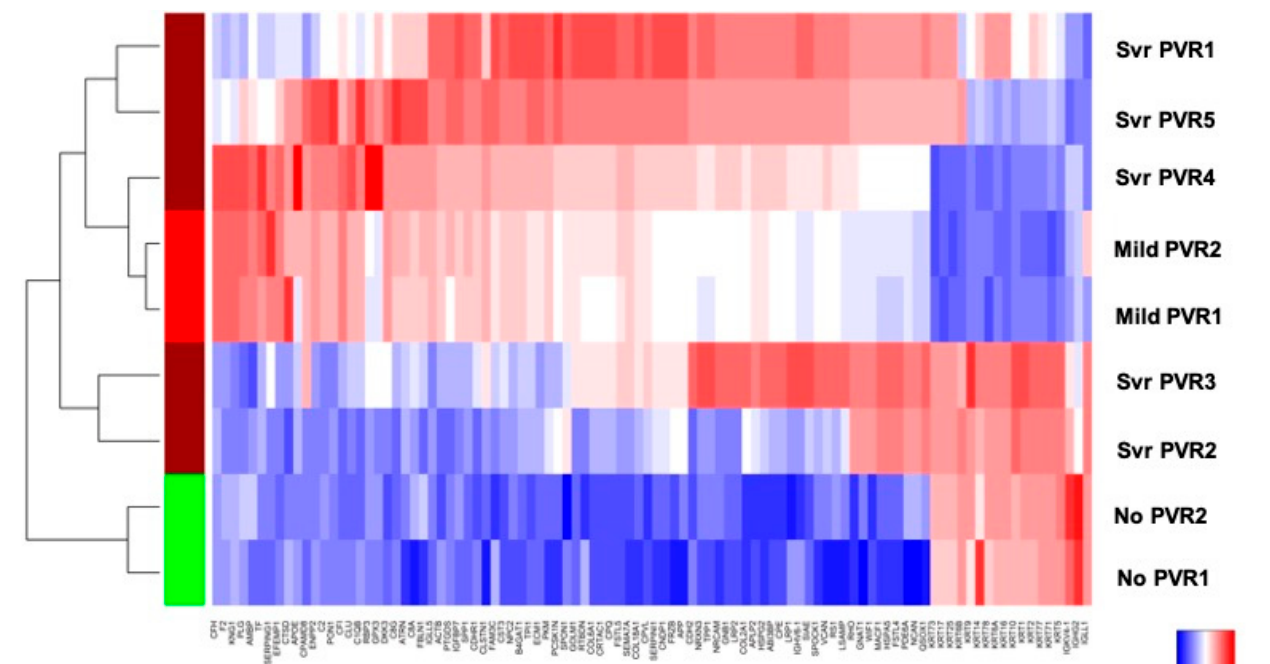
Figure 4. Differentially expressed proteins among different stages of PVR represented by hierachical clustering. A total of 176 proteins were differentially expressed between RD with no PVR, mild PVR, and severe PVR. Upregulated and downregulated proteins were determined ( fdr < 0.05). Results for top 98 proteins ( fdr < 0.01) are presented as heatmap and display protein expression levels on a logarithmic scale, rescaled to z-scores by protein. Original expression values and clustering membership details, for the 98 proteins represented in the heatmap, are listed in the supplement Table S3. The values in the heat map are normalized by gene, which fits from − 2 to 2 range.